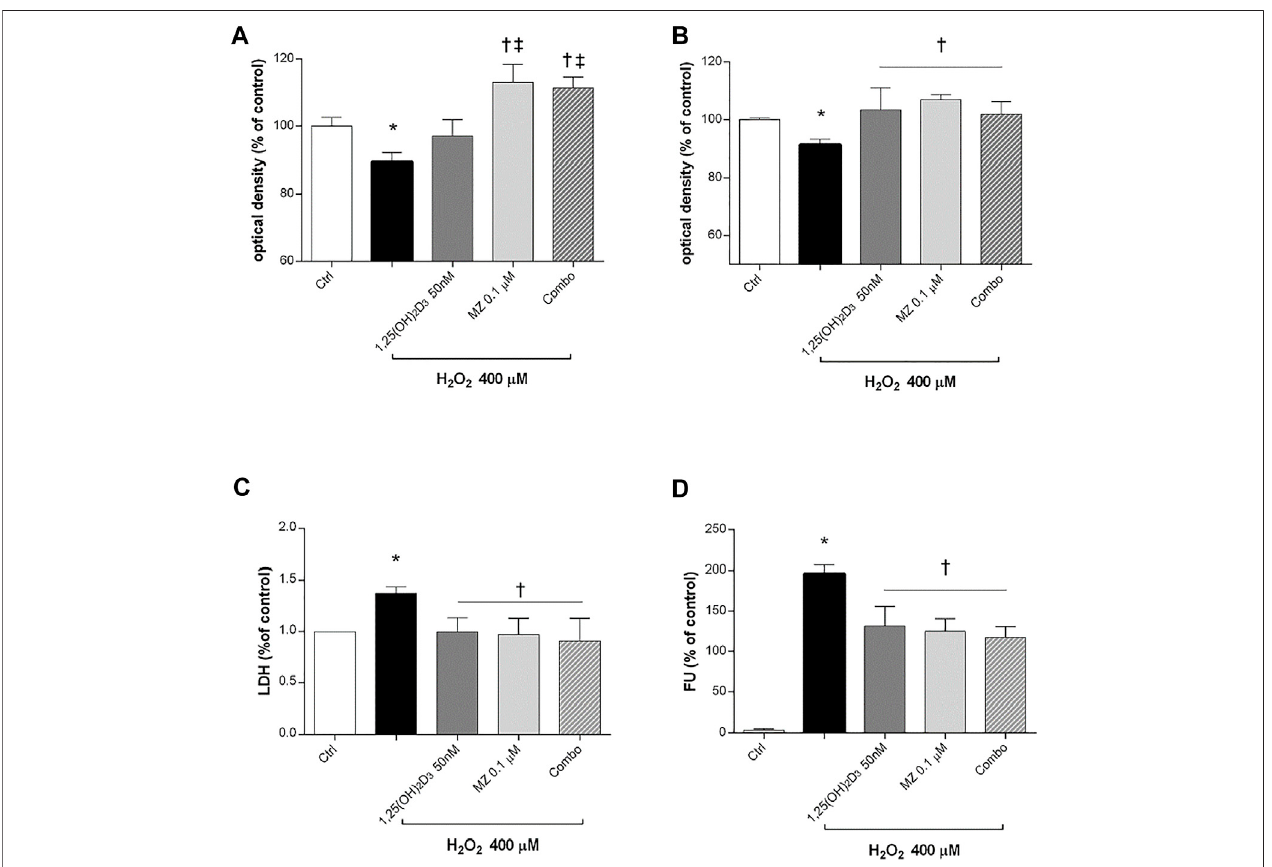
FIGURE3| 1,25(OH) 2 D 3 ,meso-zeaxanthin(MZ),andtheircombinationprotectARPE-19cellsfromoxidativedamage.ARPE-19cellswerepretreatedfor24 hwith 1,25(OH) 2 D 3 (50 nM), MZ(0.1 µM), andtheircombo(1,25(OH) 2 D 3 50 nM,MZ0.1 µM),and thentreatedwithH 2 O 2 (400 µM)fortheMTTassayat6 (A) and24 h (B).(C) LDH release of ARPE-19 cells treated for 24 h with H 2 O 2 (400 µM). (D) Pretreatment with 1,25(OH) 2 D 3 (50 nM), MZ (0.1 µM), and their combination decreased ROS ( fl uorescent units, FU) production in ARPE-19 cells, challenged for 6 h with 400 µM H 2 O 2 . The results are expressed as mean ± SD (n (cid:2) 5; each run in triplicate). Data were analyzed by one-way ANOVA and Tukey ’ s post hoc test for multiple comparisons. * p < 0.05 vs . ctrl; † p < 0.05 vs. H 2 O 2 ; ‡ p < 0.05 vs. 1,25(OH) 2 D 3